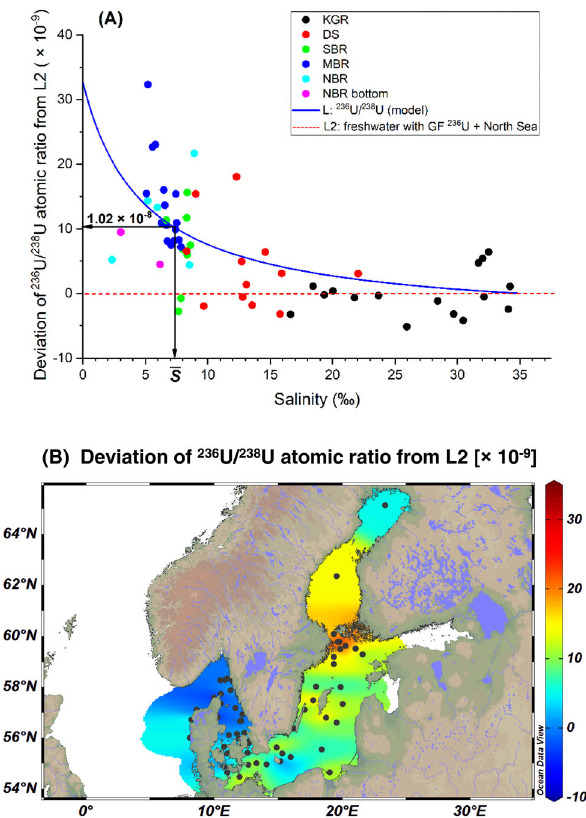
Fig. 6 Deviation of 236 U/ 238 U from L2. Deviations of 236 U/ 238 U atomic ratio from binary mixing line L2 ( A ) and their respective geographical distribution on the map ( B ). KGR Kattegat – Skagerrak region including the Kattegat, Skagerrak and Danish west coast nearby the North Sea, DS Danish Straits including the Belt Seas and the Sound, SBR South Baltic Sea region including ArkonaBasin, Borholm Basin, and South Baltic Proper, MBR Middle Baltic Searegion including Northern Baltic Proper, Western Gotland Basin, EasternGotland Basin and Gulf of Riga, NBR North Baltic Sea region includingArchipelago and Åland Sea, Bothnian Sea, and Bothnian Bay. Average salinity (cid:1) S = 7.36 ‰ . Uncertainties are expanded uncertainties using a coverage factor of k =